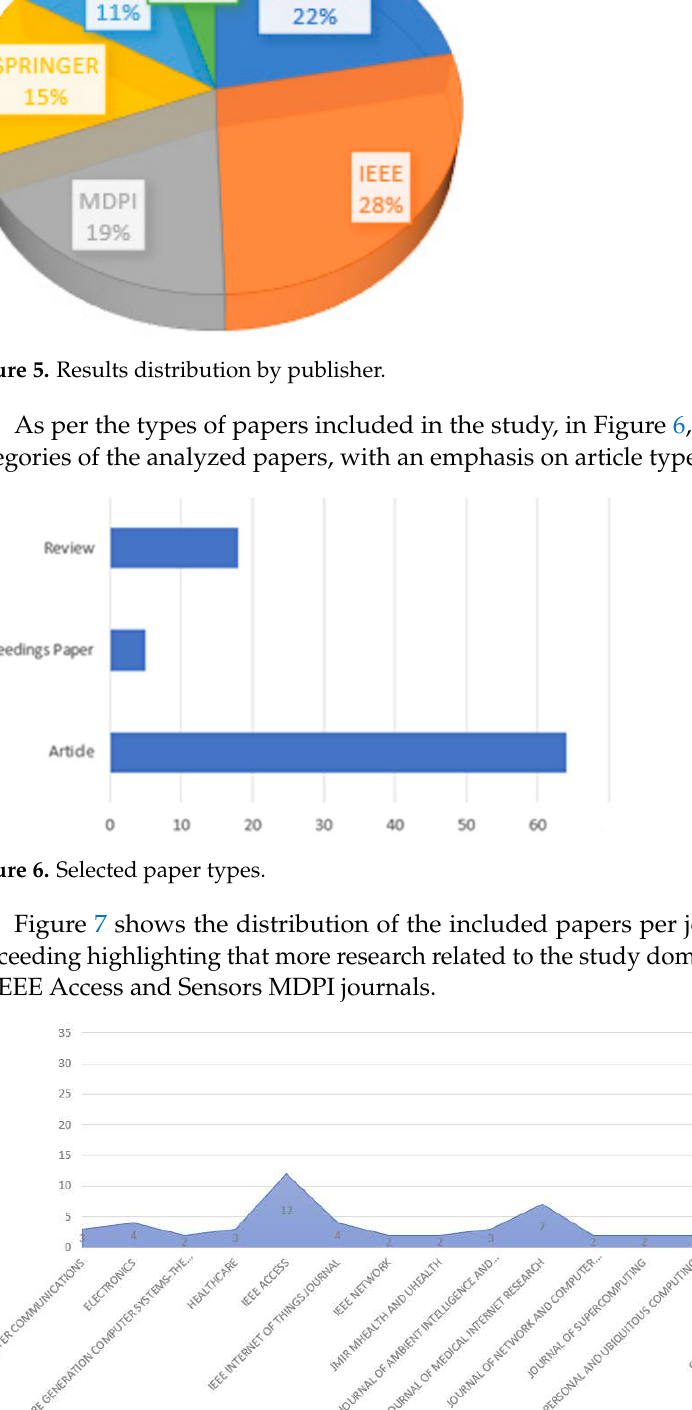
Table 2. Results overview. Search Keywords/Query Phrase Identified